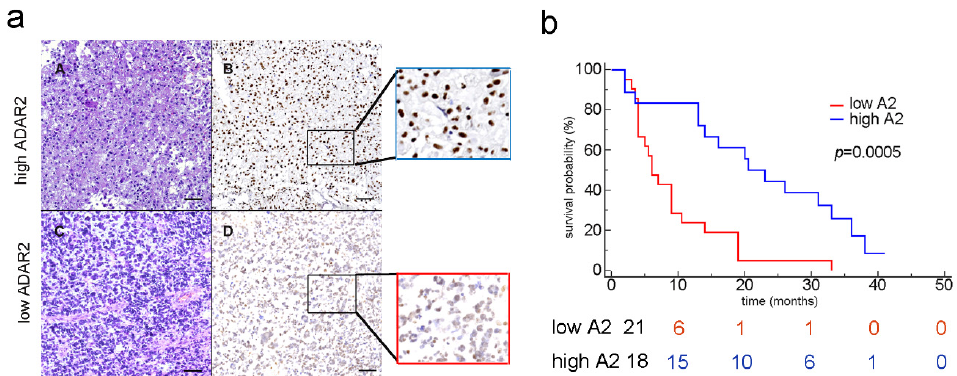
Figure 1. ADAR2 correlates with patients’ overall survival. ( a ) IHC analysis (H&E and the corre- sponding ADAR2 antibody staining) of two glioblastoma tissues (examples of high and low ADAR2 levels). Subpanels A and B show a representative GBM case with high ADAR2 expression; in sub- panels C and D, a GBM case with low ADAR2 expression is shown; scale bar: 200 µm. ( b ) Kaplan– Meier curve comparing the survival of GBM patients (n = 39) stratified by ADAR2 levels. The red and blue lines represent low and high ADAR2 expression, respectively, following the scores indicated in Material and Methods ( p = 0.0005; HR 3.954; 95% CI from 1834 to 8525).